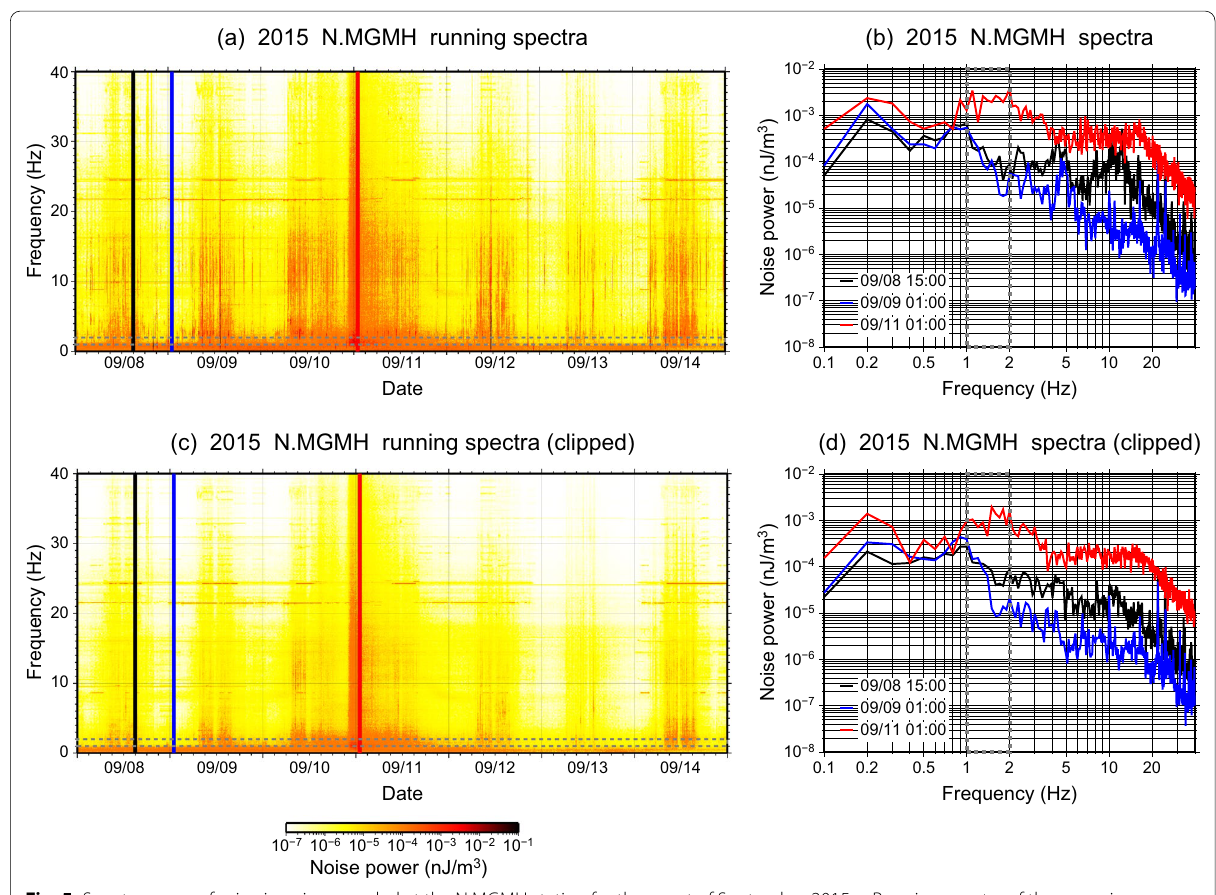
Fig. 5 Spectrograms of seismic noise recorded at the N.MGMH station for the event of September 2015. a Running spectra of the raw seismogram. b Spectra at the three time periods shown in ( a ), where black, blue, and red spectrum are obtained in the daytime, midnight, and peak streamflow periods, respectively. c Running spectra of the seismogram after “clipping” transient peaks (e.g., earthquakes). d Spectra at the three time periods shown in ( c ). The gray dashed lines in each panel represent the spectral window used for our analysis (1–2